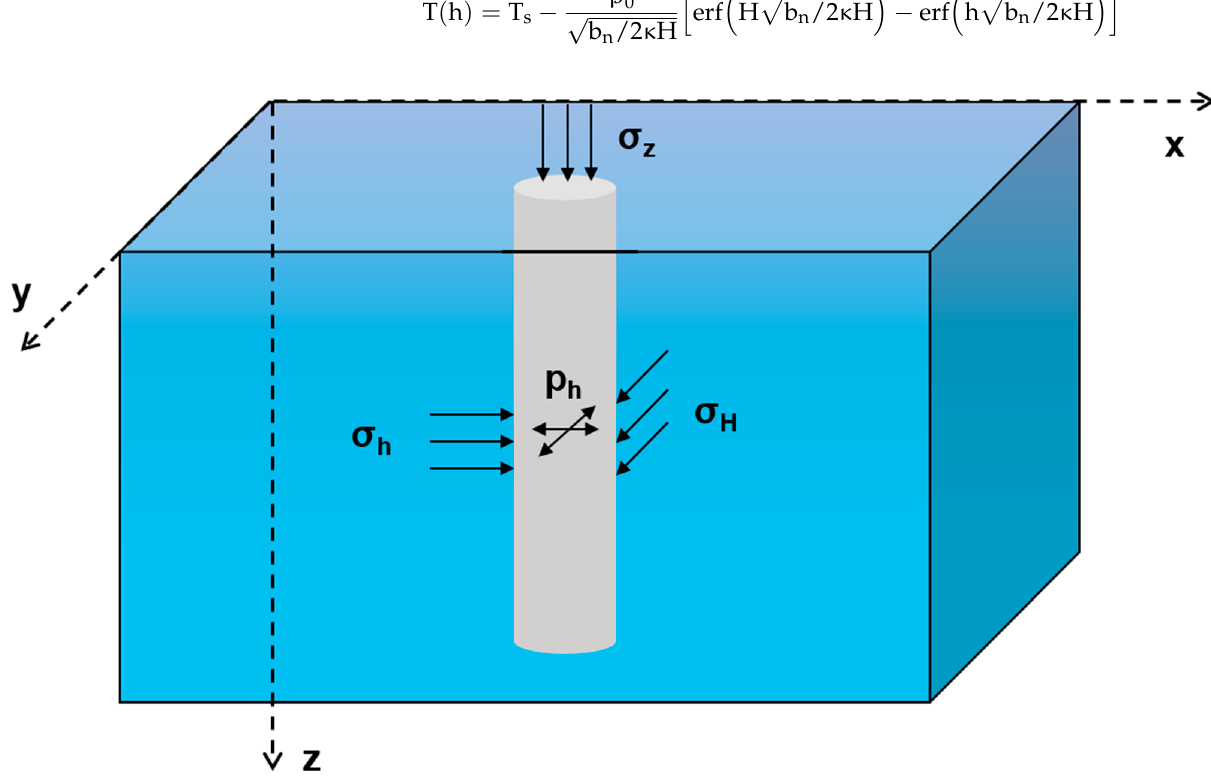
Figure 1. Stress distribution around the borehole.